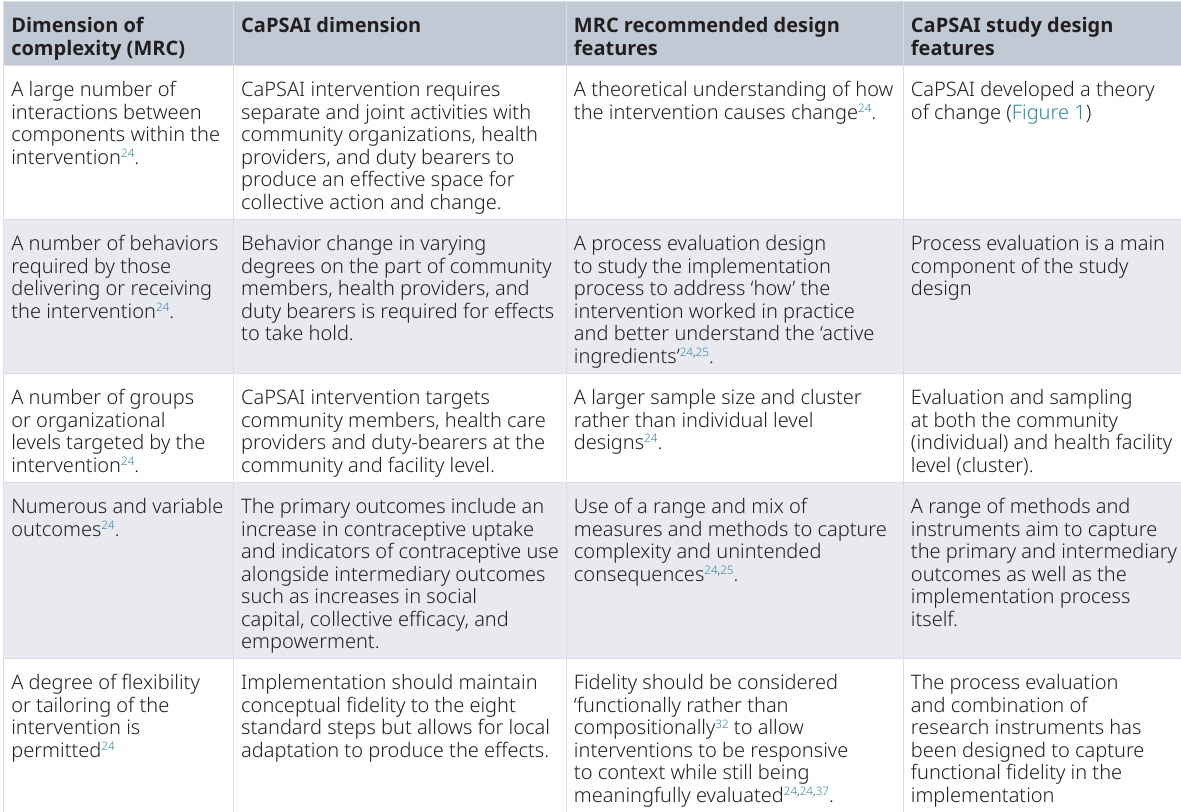
Table 4. Accounting for complexity in the Community and Provider driven Social Accountability Intervention (CaPSAI) study design. Dimension of complexity